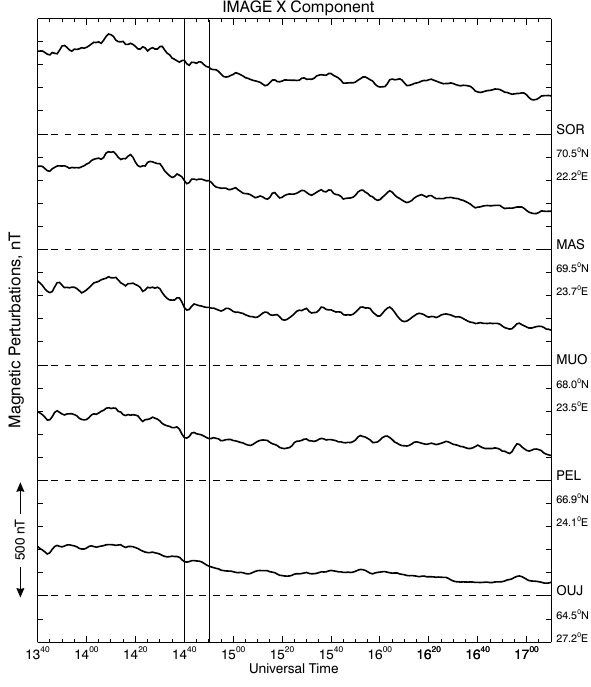
Fig. 5. The X-components of the IMAGE magnetometer network on 31 March 2000, 13:40–17:10 UT, for five stations close to the region of interest in 1-min resolution. The station geographic coor- dinates and three-letter station abbreviations are shown on the right. Two vertical lines denote 10-min interval 14:40–14:50 UT, the data from which were presented in Figs.